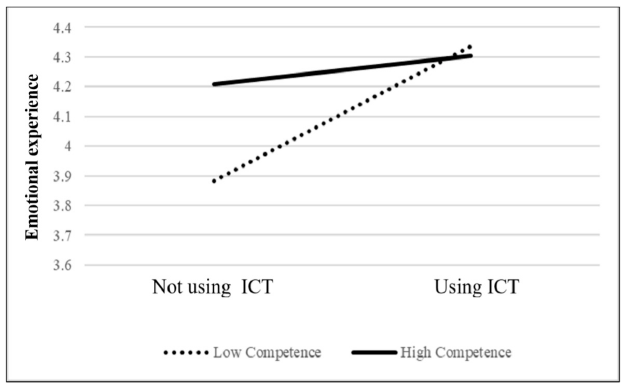
Figure 1. Moderating effect of ICT usage and competence on emotional experience.